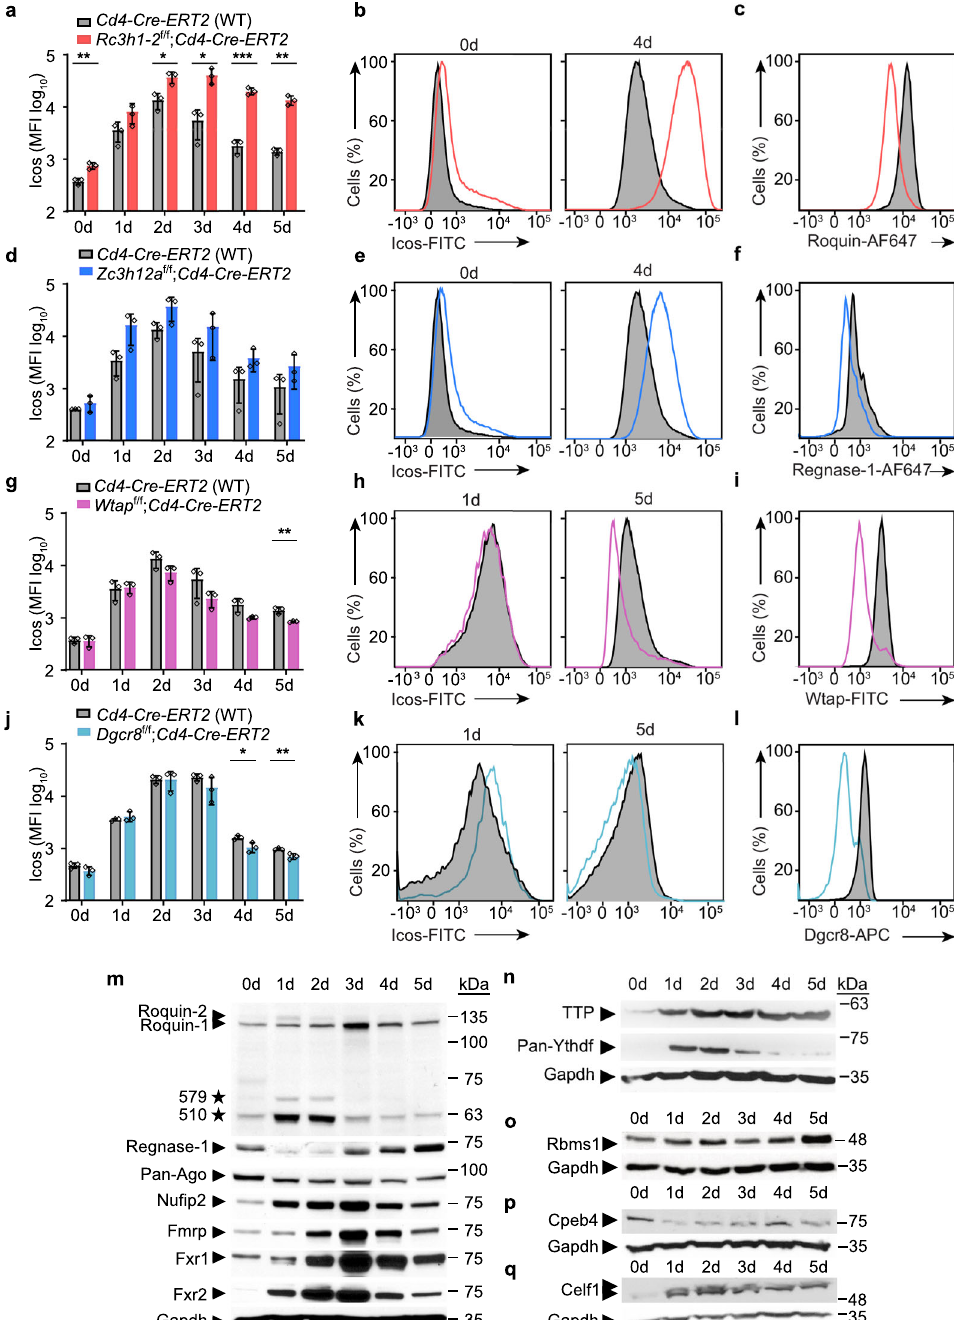
Fig. 1 Icos responds to simultaneous inputs from several post-transcriptional regulators. Naive CD4 + T cells (d0) from tamoxifen-gavaged mice of the indicated genotypes were activated by anti-CD3/anti-CD28 (day1 – 2) and subsequently cultivated in IL-2 containing media (d4 – 5). a , d , g , j Bar diagrams show the average of daily fl ow cytometric measurements of Icos expression with quanti fi ed mean fl uorescence intensities (MFI) over a 5-day period to analyze changes due to inducible inactivation of Roquin-1 and Roquin-2 ( Rc3h1 and Rc3h2 ), Regnase-1 ( Zc3h12a ) Wtap or Dgcr8. Signi fi cance was calculated using the unpaired t -test (two- tailed) for data from three independent experiments using one mouse per genotype ( n = 3). Error bars, mean±s.d. b , e , h , k Representative histograms of Icos expression at the speci fi ed days. c , f , i , l Histograms con fi rming depletion of the respective target proteins. m – q Western blots showing patterns of dynamic RBP regulation after anti-CD3/CD28 mediated T cell activation ( n = 2). signi fi cance * p value = 0.01 – 0.05; ** p value = 0.001 – 0.01; *** p value = <0.001. Calculated p values: ( a ) 0d p = 0.005, 2d p = 0.016, 3d p = 0.012, 4d p = 0.0005, 5d p = 0.0017, ( g ) 5d p = 0.009, ( j ) 4d p = 0.022, 5d p = 0.009. Source data are provided as a Source Data fi le.